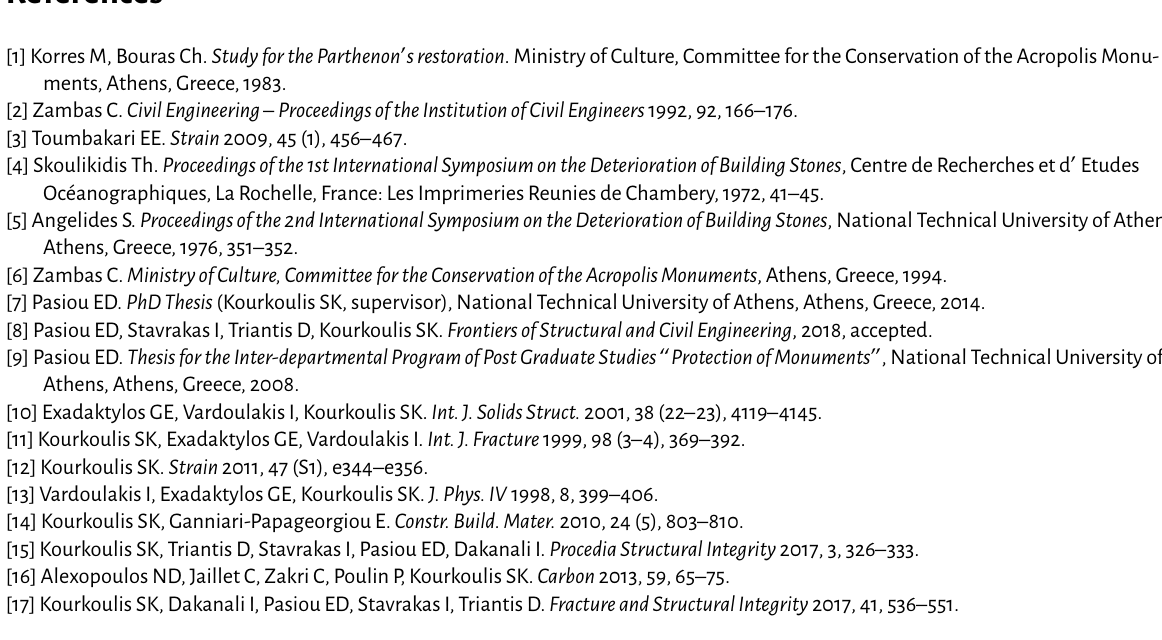
Figure 14: The variation of the equivalent von Mises stress developed along the height of epistyles in case of (A) com- bined loading and (B) angular